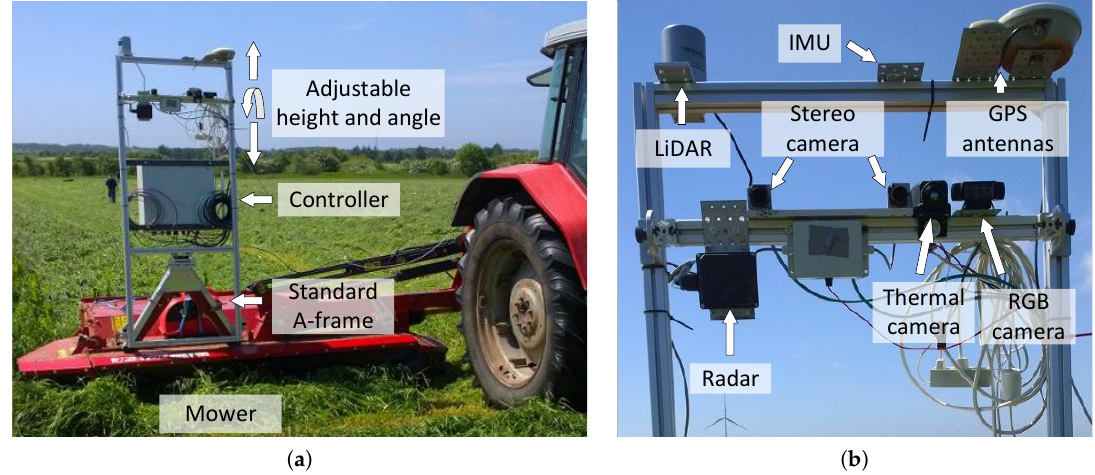
Figure 2. Sensor frame including the controller ( a ). Sensors on the sensor platform ( b ). Figure taken from